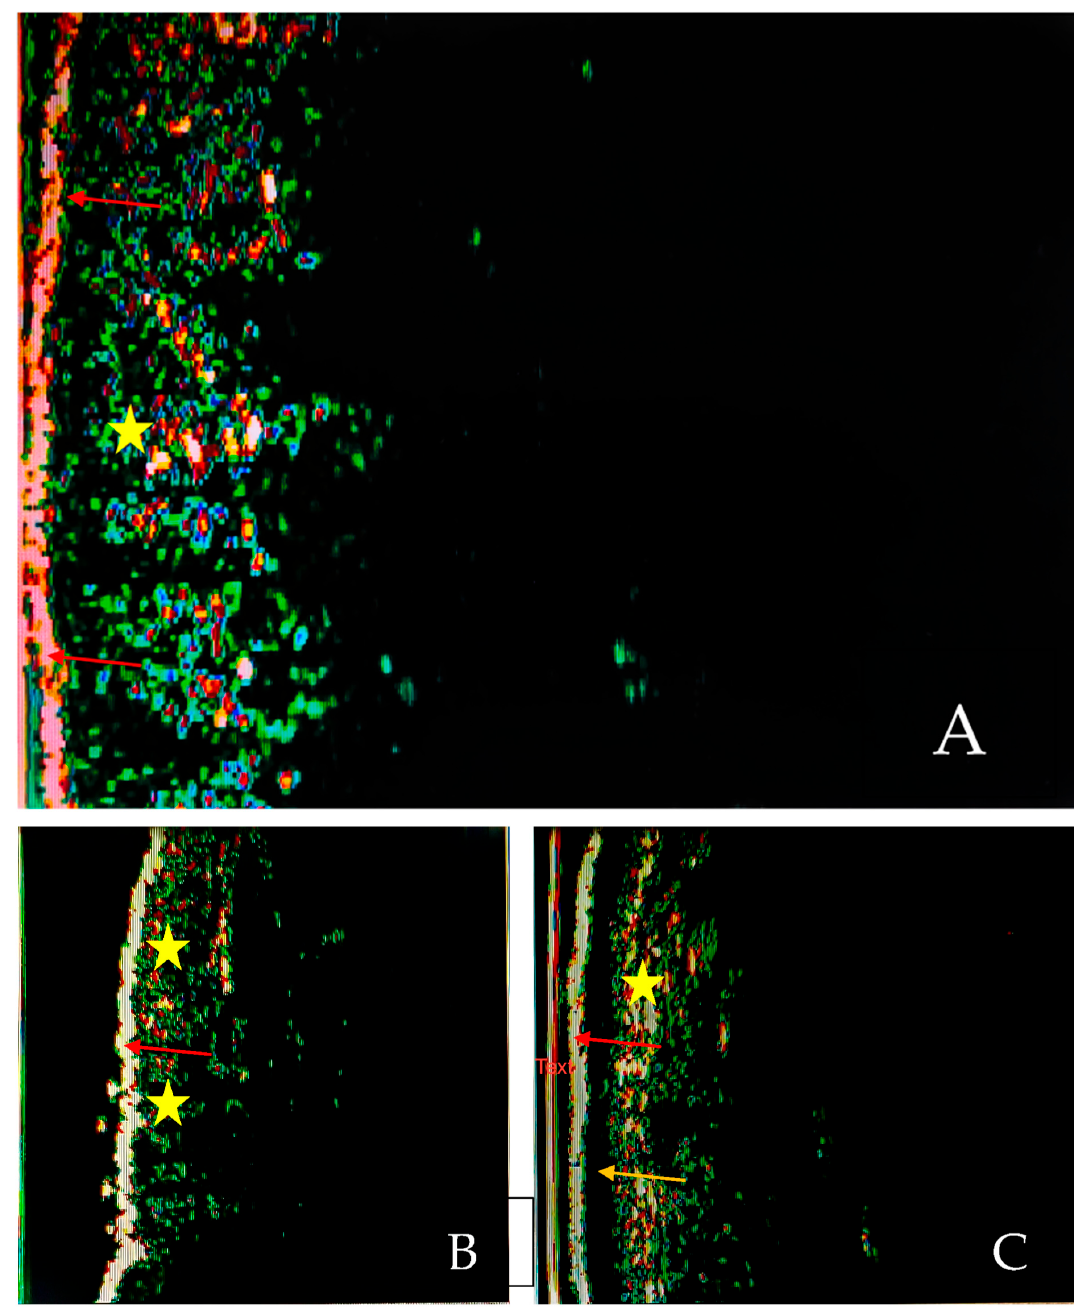
Figure 2. HF-USG aspects of normal skin ( A ) and skin with atopic dermatitis ( B ) and psoriasis ( C ). Visualization of epidermis (red arrows), SLEB (yellow arrow) and dermis (yellow star). The images were captured using a device with a 20 Mhz transducer (personal library of Dr. Alin Nicolescu).